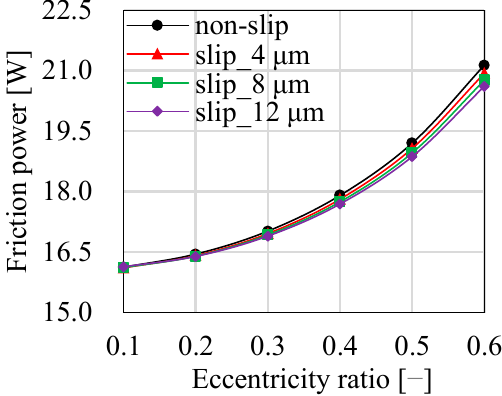
Figure 12. Friction power under different slip lengths.